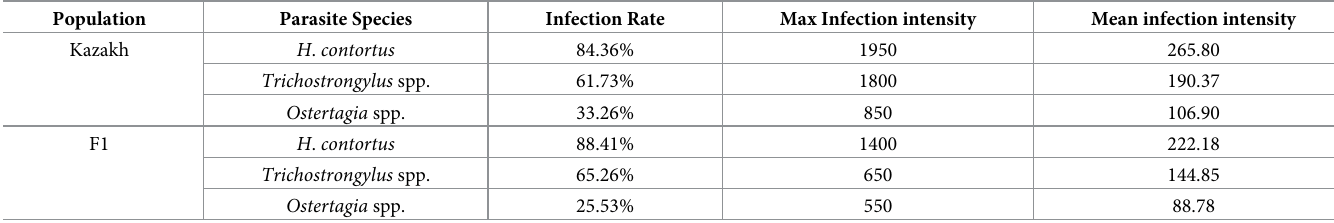
Table 10. Dominant species of sheep GINs in